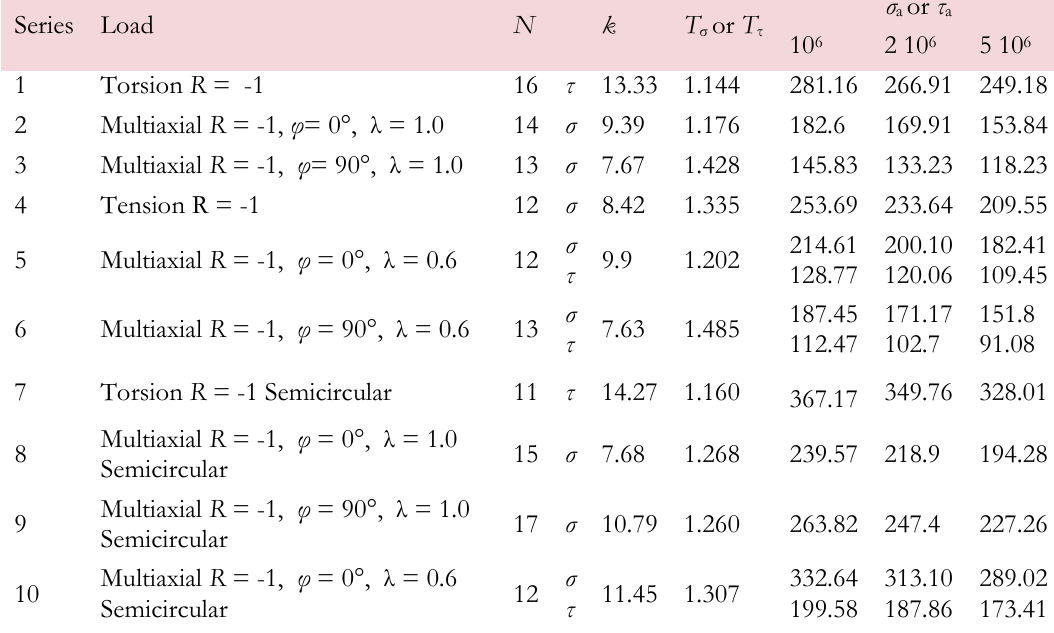
Table 3: Results from fatigue tests. Mean values, Ps=50%. Stresses referred to the net